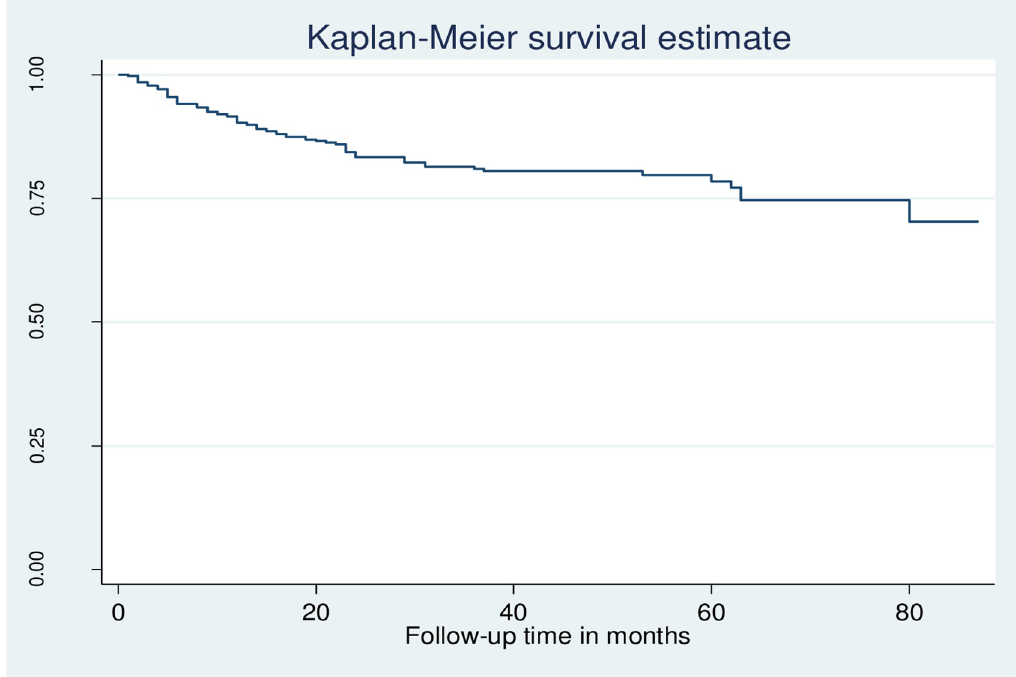
Fig 1. The overall Kaplan-Meier survival estimate curve of adult HIV positive patients on ART in public health facilities of Arba Minch town, southern Ethiopia, 2020.